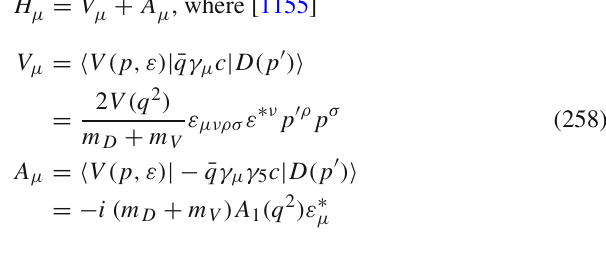
Table278.The χ 2 perdegreeoffreedomofthecombinedfitis 51 /